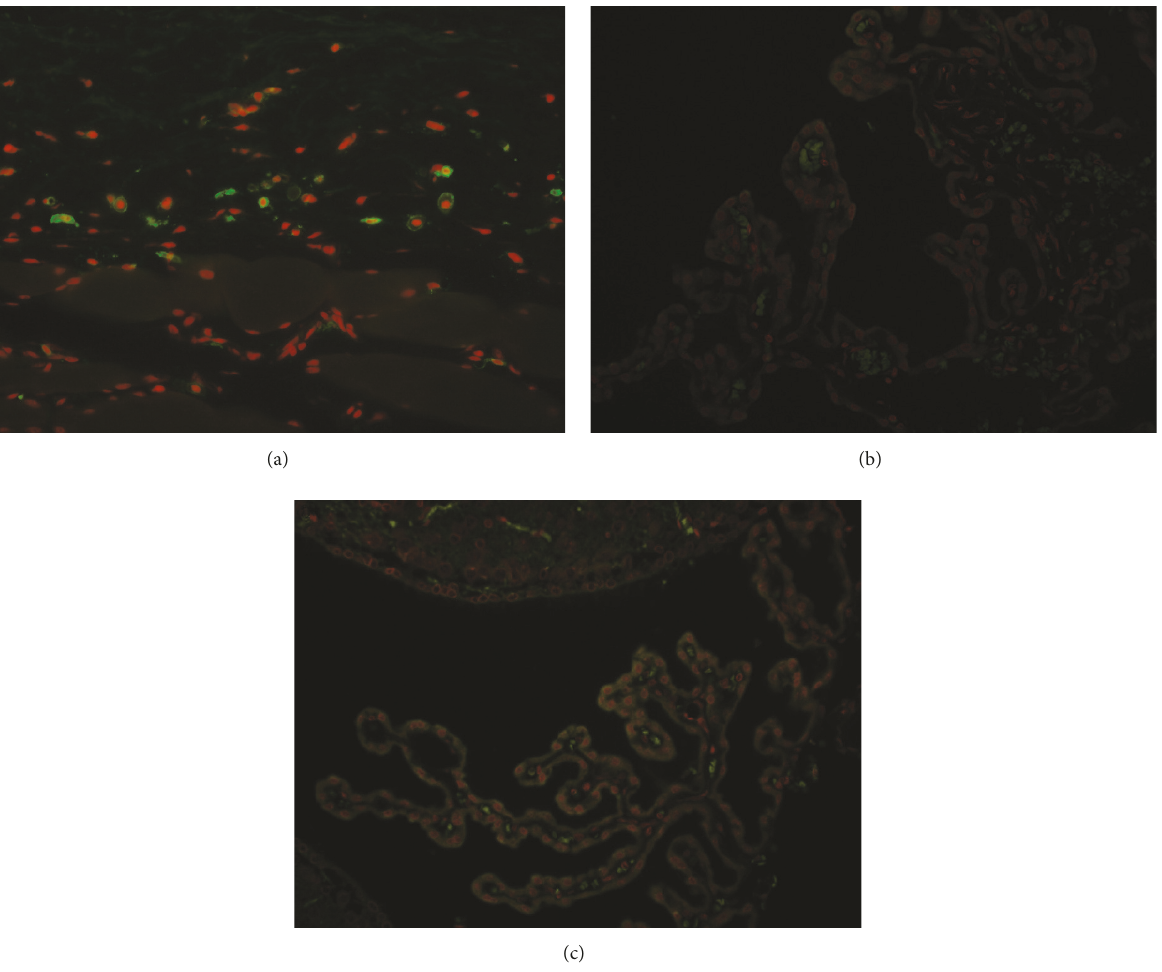
Figure 2: Immunohistochemical detection of polyethylene glycol (PEG) in (a) macrophages in subcutaneous tissue from a rat injected subcutaneously with 40kDa PEG (positive control), (b) choroid plexus from rat dosed with 0IU N8-GP/kg every fourth day for 52 weeks (negative control), and (c) choroid plexus from a rat dosed with 1200IU N8-GP/kg every fourth day for 52 weeks. In (a), fluorescent green staining represents PEG content in macrophages. In (b) and (c), green staining represents autofluorescence staining of red blood cells in the core of the choroid plexus. Red staining in (a), (b), and (c) represents